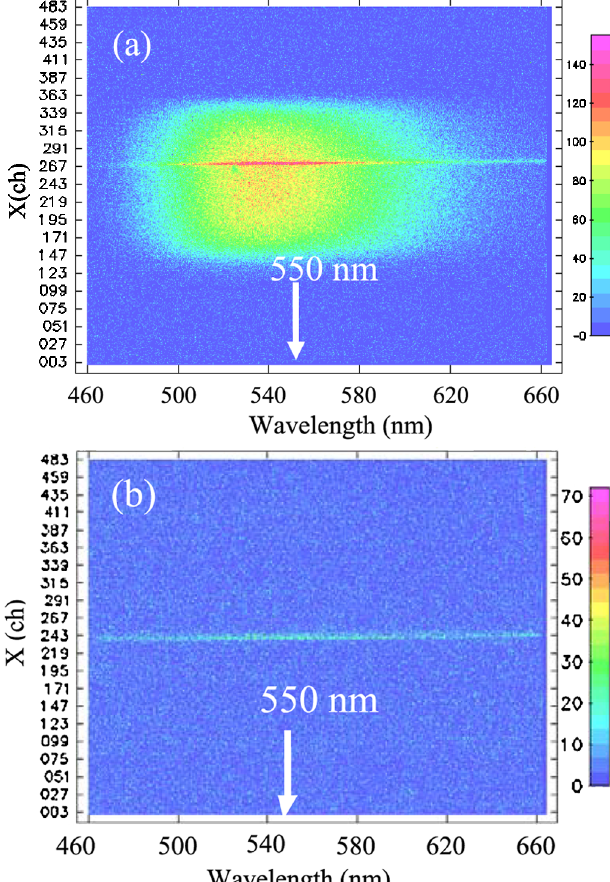
FIG. 7. (Color) Example x - (cid:2) images of the present PC gun beam at 375 MeV near maximum bunch compression for (a) YAG:Ce screen plus ‘‘COTR streak’’ and (b) the COTR screen only. In this case the 95 lines = mm grating was selected in the spectrome- ter, and the wavelength span is about 180 nm. The broadband emission streak is clearly from a localized x location in both